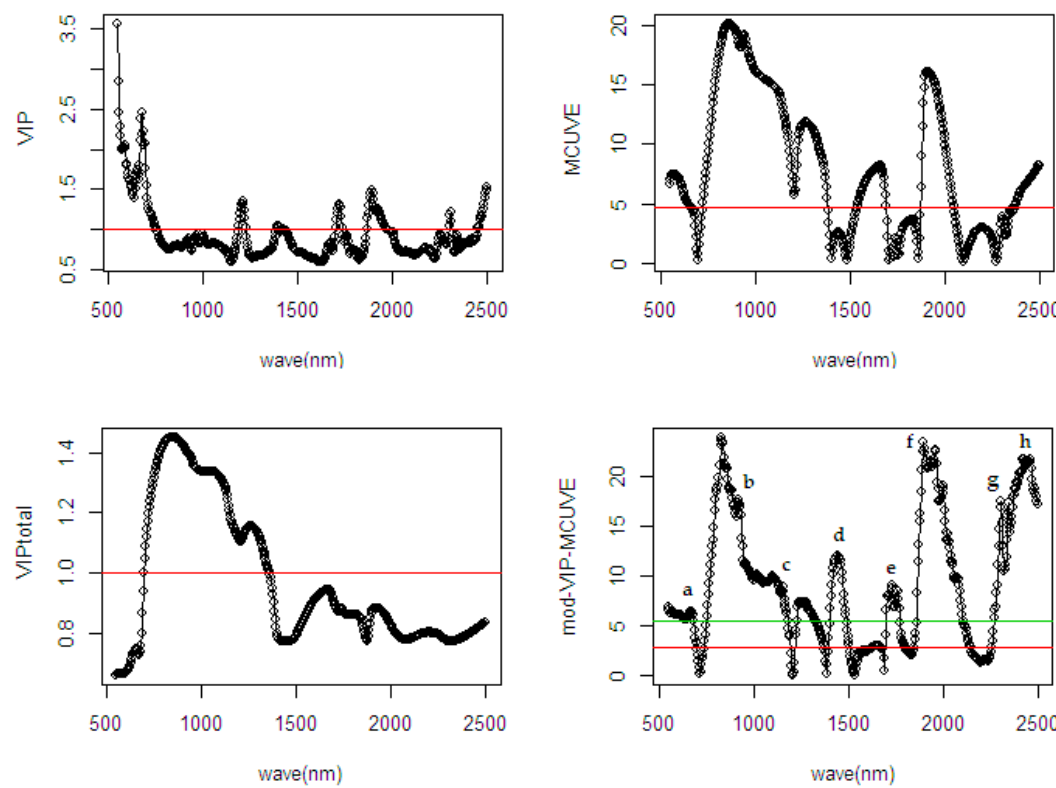
Figure 7. Comparison of selected wavelengths from di ff erent wavelength selection methods using spectral data of fresh fruit mesocarp on the